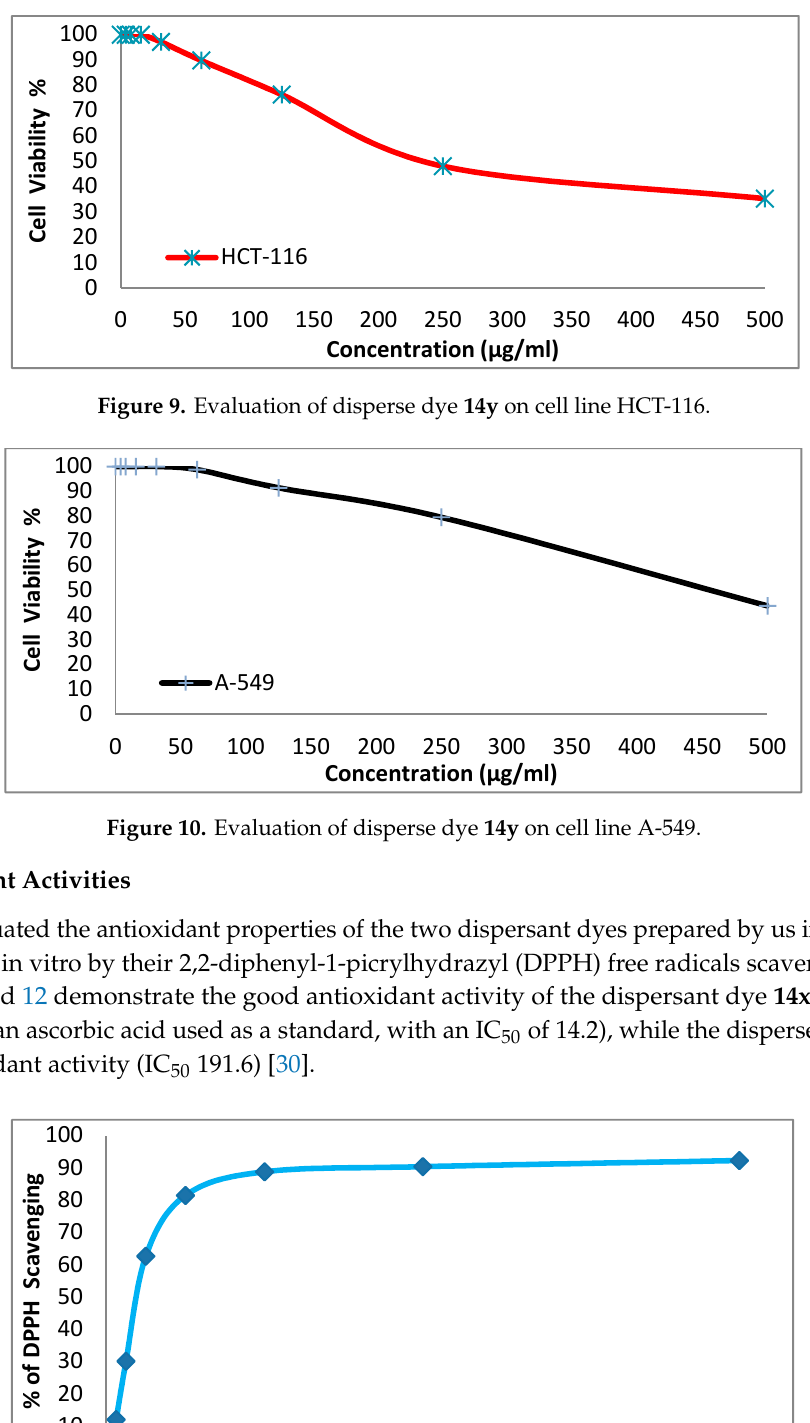
Figure 11. Evaluation of the antioxidant effect of disperse dye 14x.